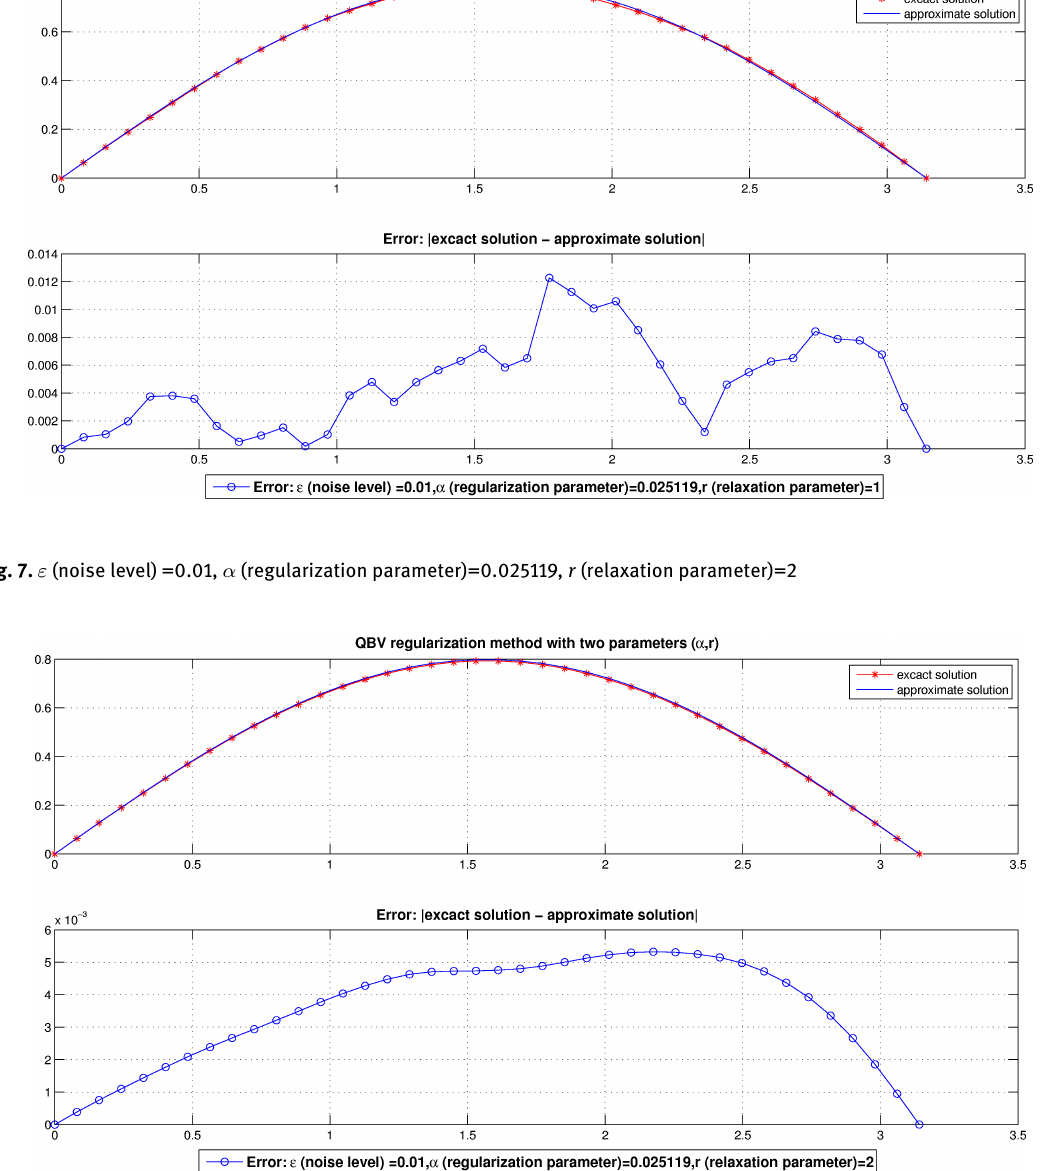
● In the case r = 0, ε = 0.001 and α = 0.015849 (resp. r = 0, ε = 0.01 and α = 0.025119),